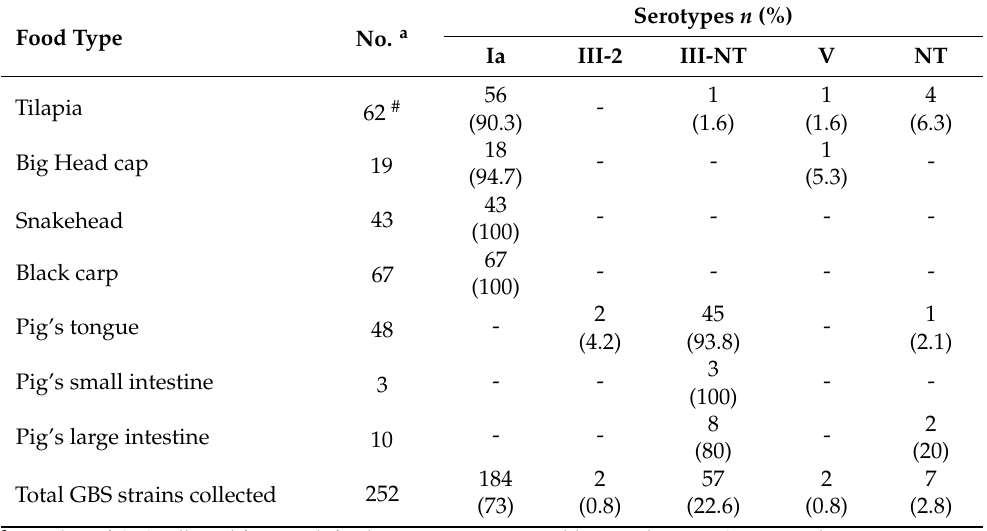
Table 3. Serotype distribution of S. agalactiae isolated from freshwater fish and pig